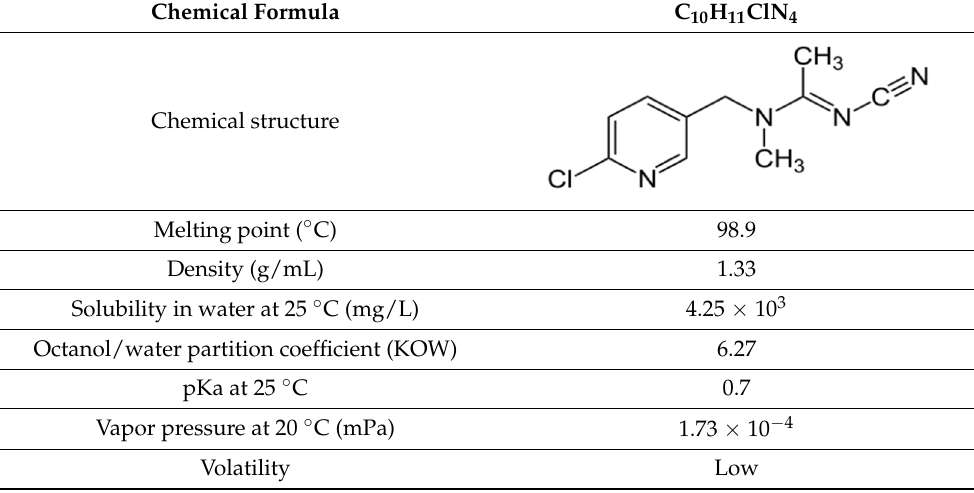
Table 2. Acetamidprid physicochemical characteristics. Chemical